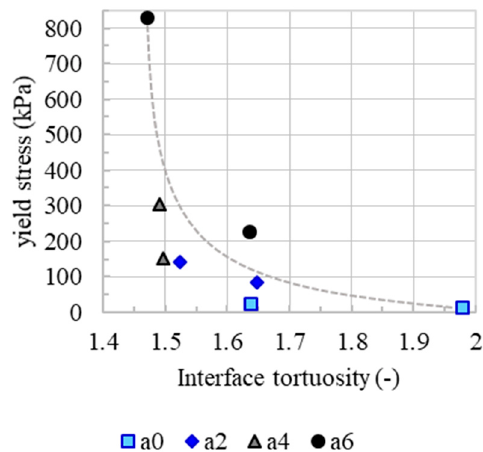
Figure 13. Reduction of Interface tortuosity with increasing yield stress. Exemplary shown for the specimen a0–a6 with interlayer time 5 and 30 min.